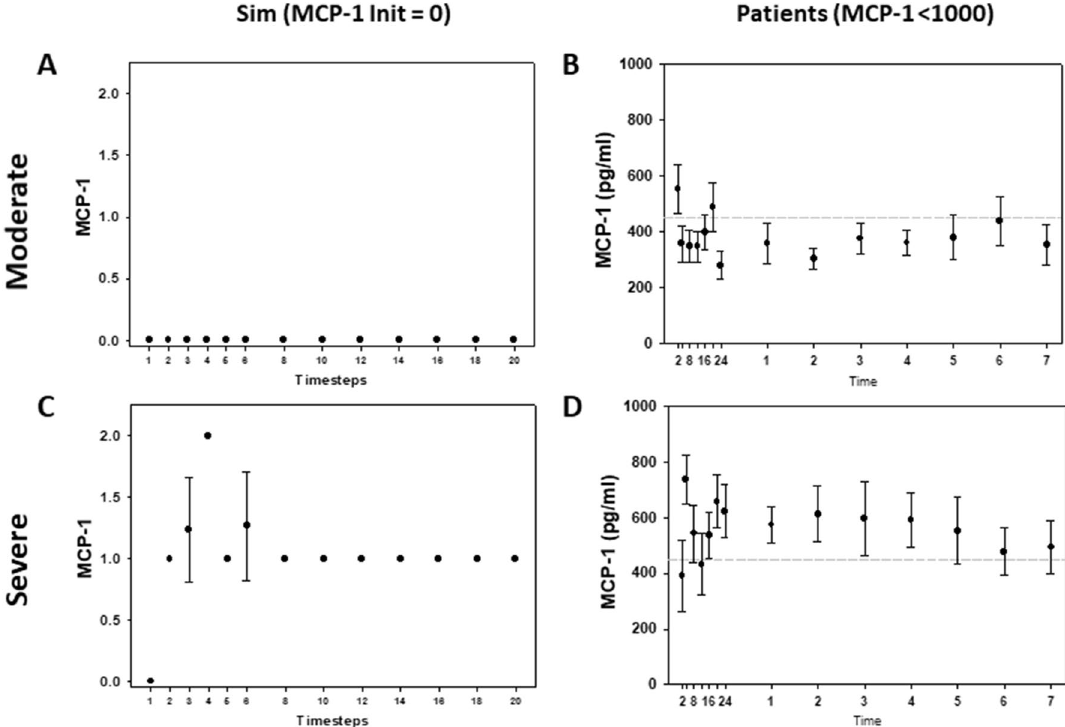
Figure 5. Logical model captures differences in Moderate vs. Severe Injury patients with low MCP-1. Simulation with moderate injury and low initial MCP-1 (Panel A ) shows MCP-1 remaining low, whereas simulation with severe injury and low initial MCP-1 (Panel C ) shows a rise and higher sustained MCP-1 levels. Similarly, patients with low initial MCP-1 and moderate injury (Panel B ) exhibit lower MCP-1 levels throughout time course as compared to patients with severe injury (Panel D ). Data in (Panels B vs. D ) are significantly different (P < 0.05) by Two-Way